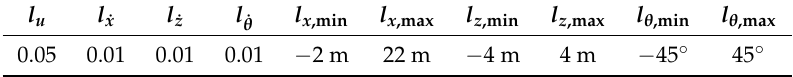
Table 4. Parameters used by the RL reward